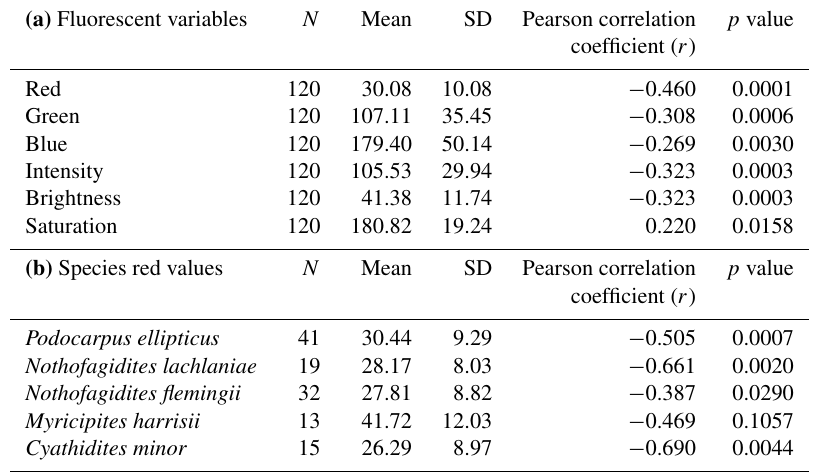
Table 1. Pearson’s correlation coefficient values of the (a) fluorescence variables (RGB, intensity, brightness, and saturation) and (b) red values of each taxon measured, along with sample size, mean, standard deviation (SD), and p values. (a) Fluorescent variables N Mean